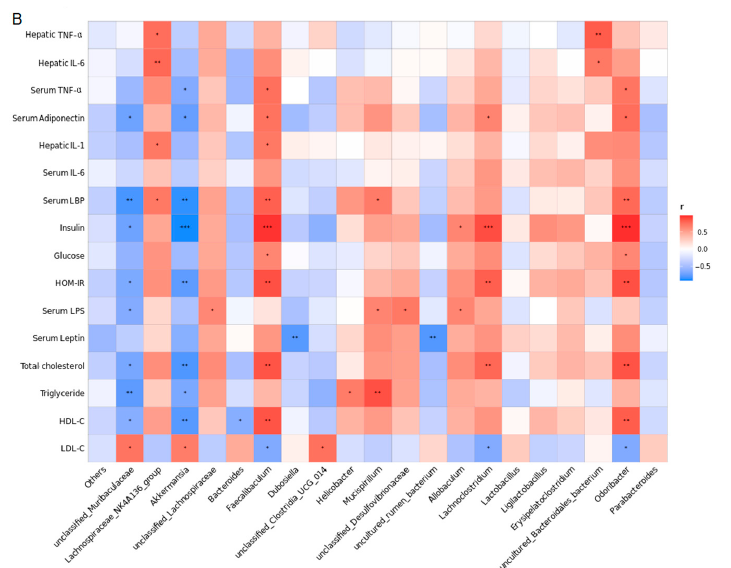
Figure 7. Results of correlation analysis. ( A ) Correlation heat map between the 16 serum metabolite biomarkers and risk factors of NAFLD from the HF-HF and HF-HF + sesamolin groups. ( B ) Correla- tion heat map between the 20 most dominant genera and risk factors of NAFLD from the HF-HF and HF-HF + sesamolin groups. * p < 0.05; ** p < 0.01; *** p <